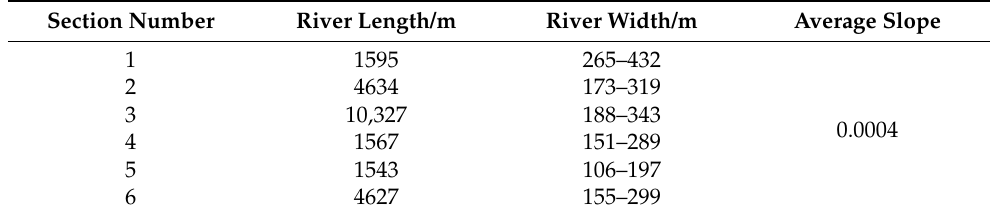
Table 6. Observations of volume flow in Kootenai